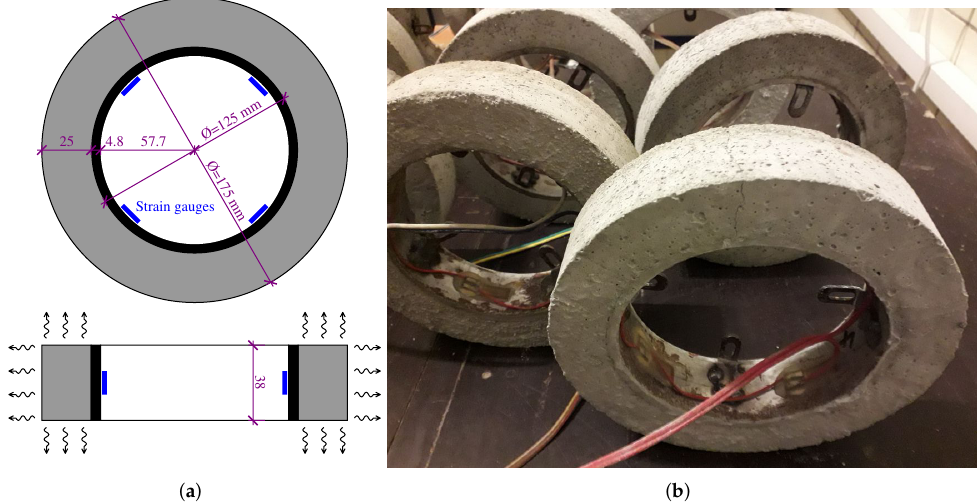
Figure 5. Adopted ring geometry with four strain gauges ( a ) and a cracked ring ( b